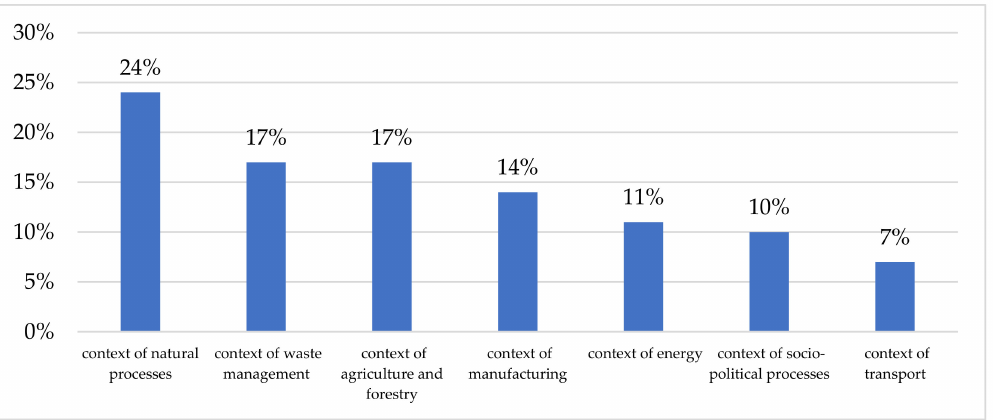
Figure 3. Context of reflection on climate change in parliamentary pre-election